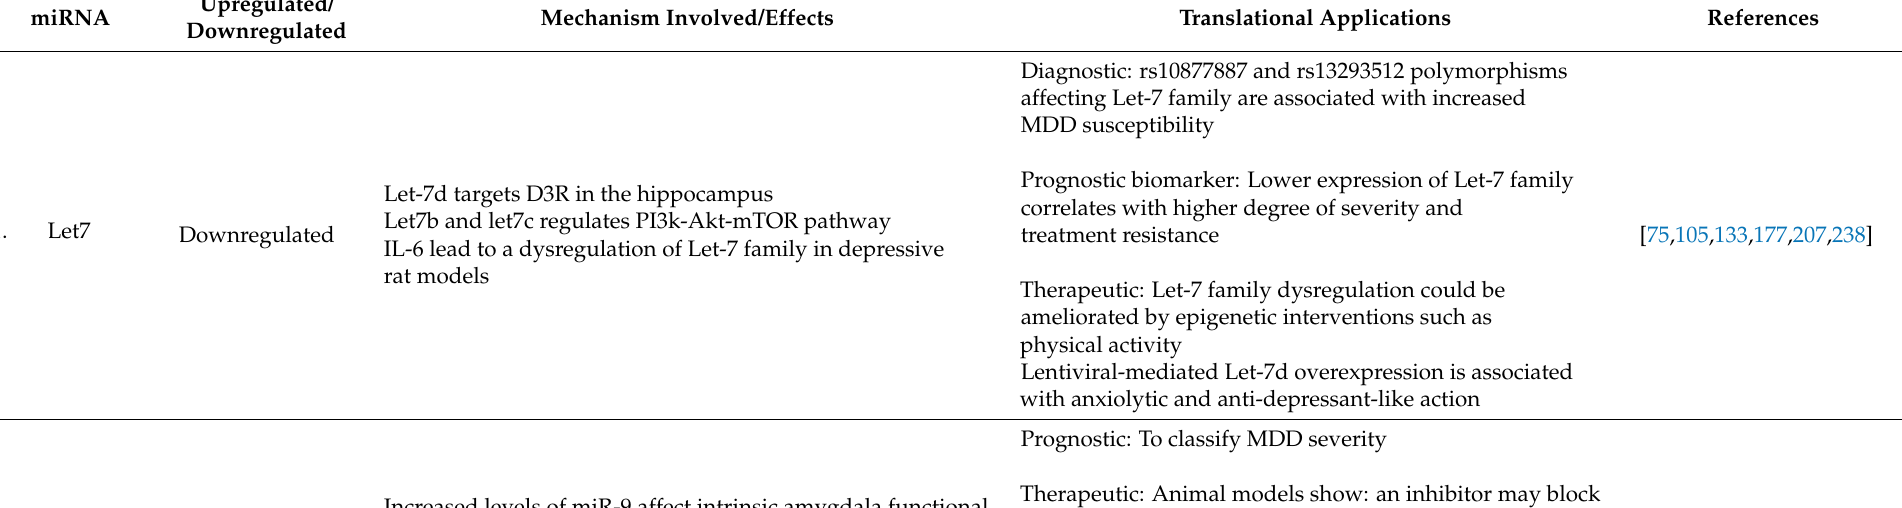
Table 1. A summary of the different miRNAs up or downregulated involved in the pathophysiology of depression, as well as their potential translational applications.